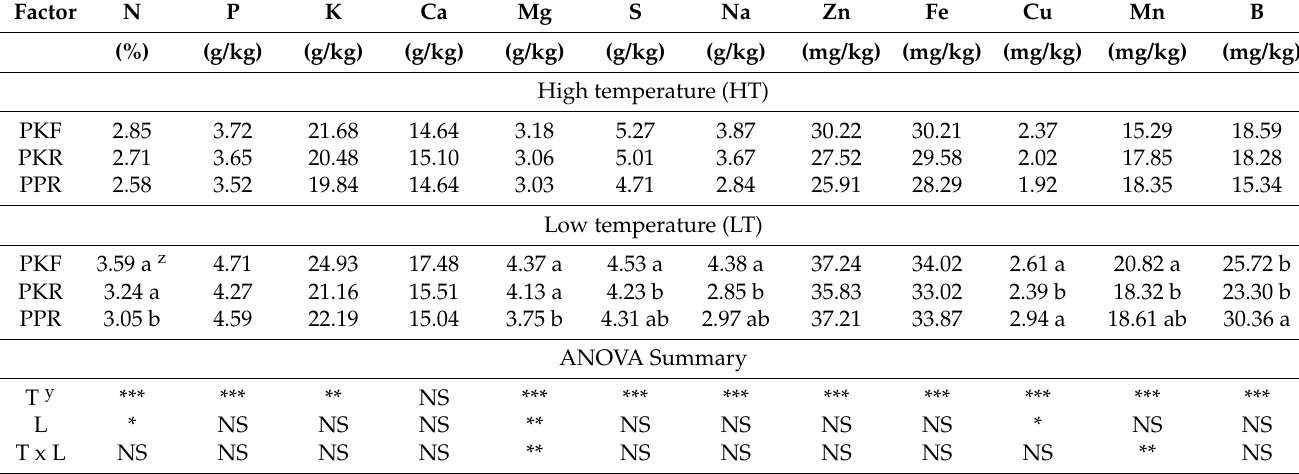
Table 2. Macronutrients of nitrogen (N), phosphorus (P), potassium (K), calcium (Ca), magnesium (Mg), and sulfur (S); and micronutrients of sodium (Na), zinc (Zn), iron (Fe), copper (Cu), manganese (Mn), and boron (B) of ‘Cegolaine’ lettuce ( Lactuca sativa ) plants grown under two temperatures: high and low (HT, LT) and three light spectra: PKF (blue, 8%, green 15%, red 72%, FR 5%), PKR (blue 8%, green, 15%, red 77%), and PPR (blue 13%, red